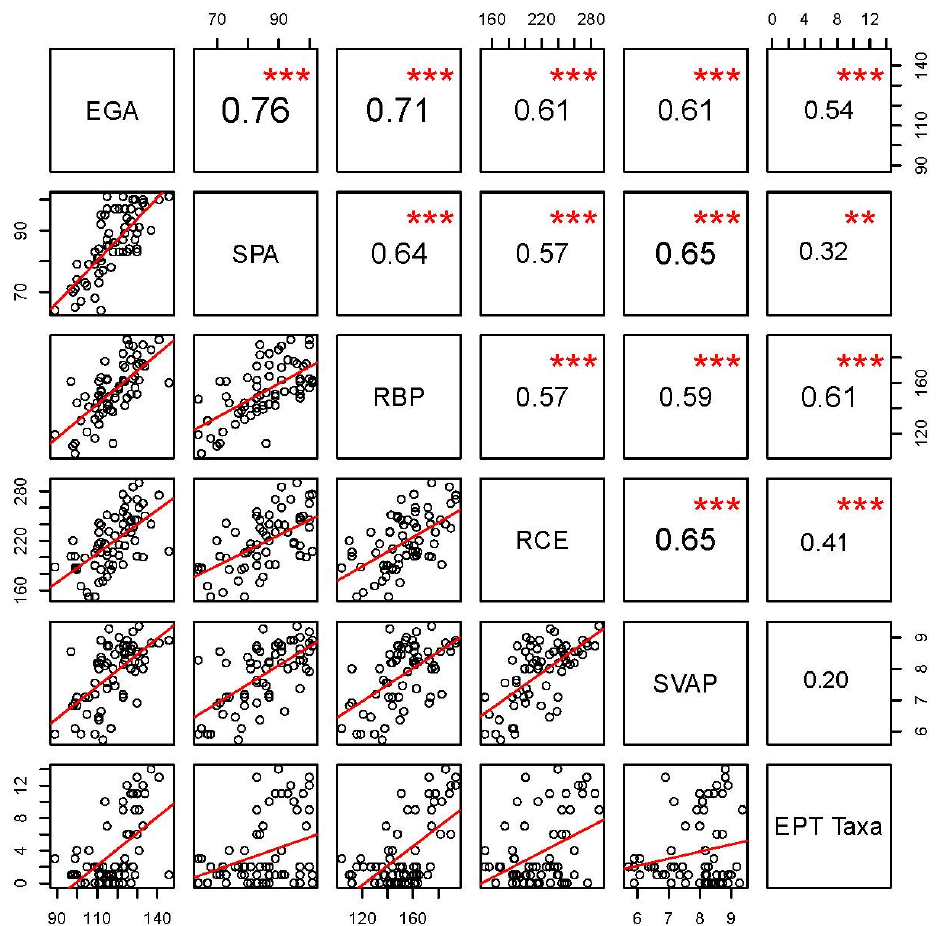
Figure 2. Correlation visualization diagram comparing total raw points for five stream assessment methods and EPT Taxa values for 65 streams using correlation, results of test for association between paired samples using Pearson’s correlation coefficient and bivariate scatterplots with a weighted least squares fitted line. Significance indicated by *** ≤ 0.0001, ** ≤ 0.001, * ≤ 0.01. The x-axis (including axis scale) for each scatterplot corresponds to the column label (vertical) and the y-axis corresponds to the row label (horizontal).